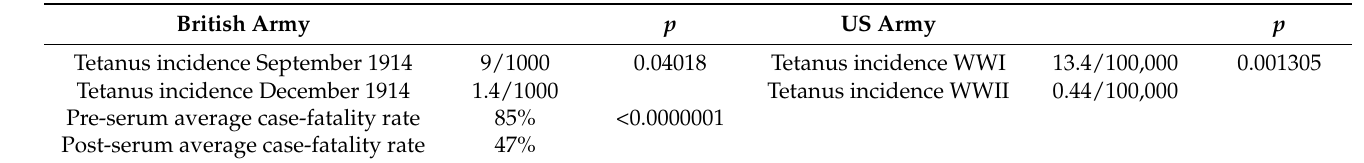
Table 4. Effectiveness of prophylactic hyper-immune anti-tetanus serum in the British Army in